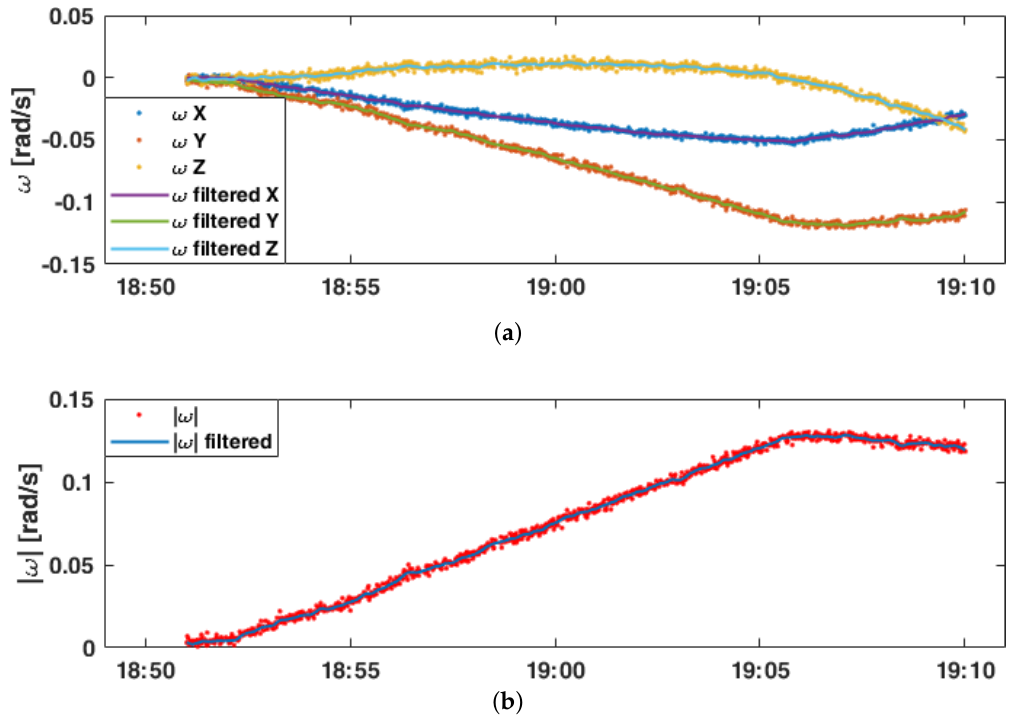
Figure 14. Smoothing of angular rate data as preparation for thrust estimation. Raw (dots) vs. smoothed (line) angular rate data during thruster B firing on 31 May 2020. ( a ) Angular rate about the single body axes. ( b ) Absolute magnitude of the angular